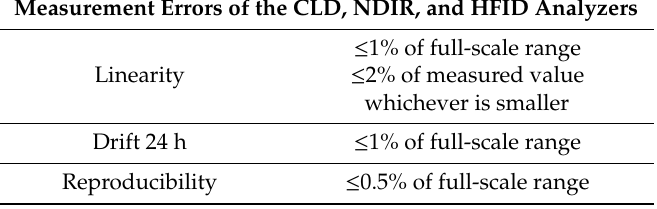
Table 3. Manufacturer’s data for the measurement errors of the CLD, NDIR, and HFID analyzers. Measurement Errors of the CLD, NDIR, and HFID